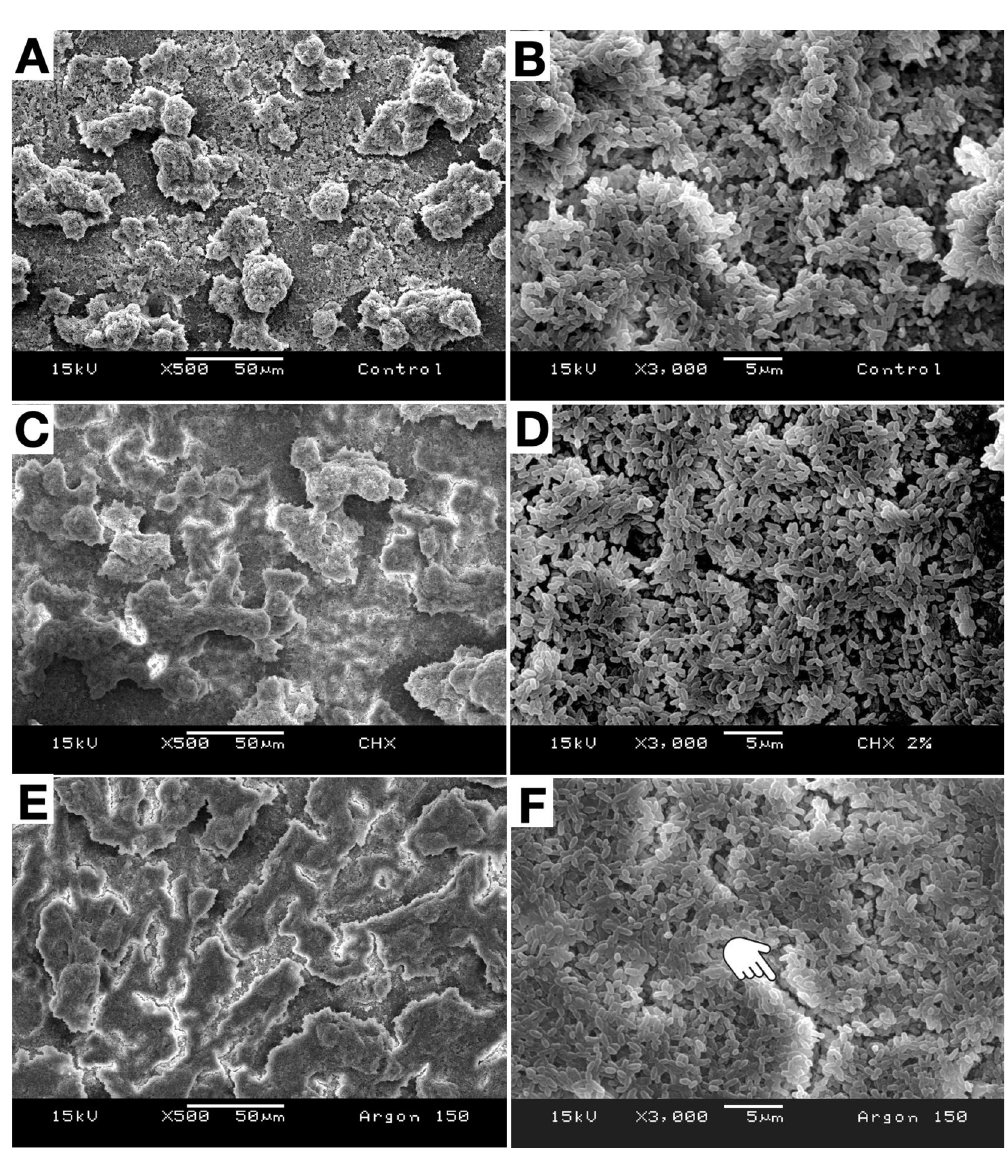
Figure 3. Representative SEM micrographs of the S. mutans biofilm (24 h, X500 and X3000 magnification) are shown after the following treatments: CON ( A , B ); CHX ( C , D ); and ARG ( E , F ). Note that the biofilm in ARG more compact appearance ( E , F ) when compare with the CON ( A , B ), some ruptures ( F ) occurred on the biofilm in ARG due to effects of drying